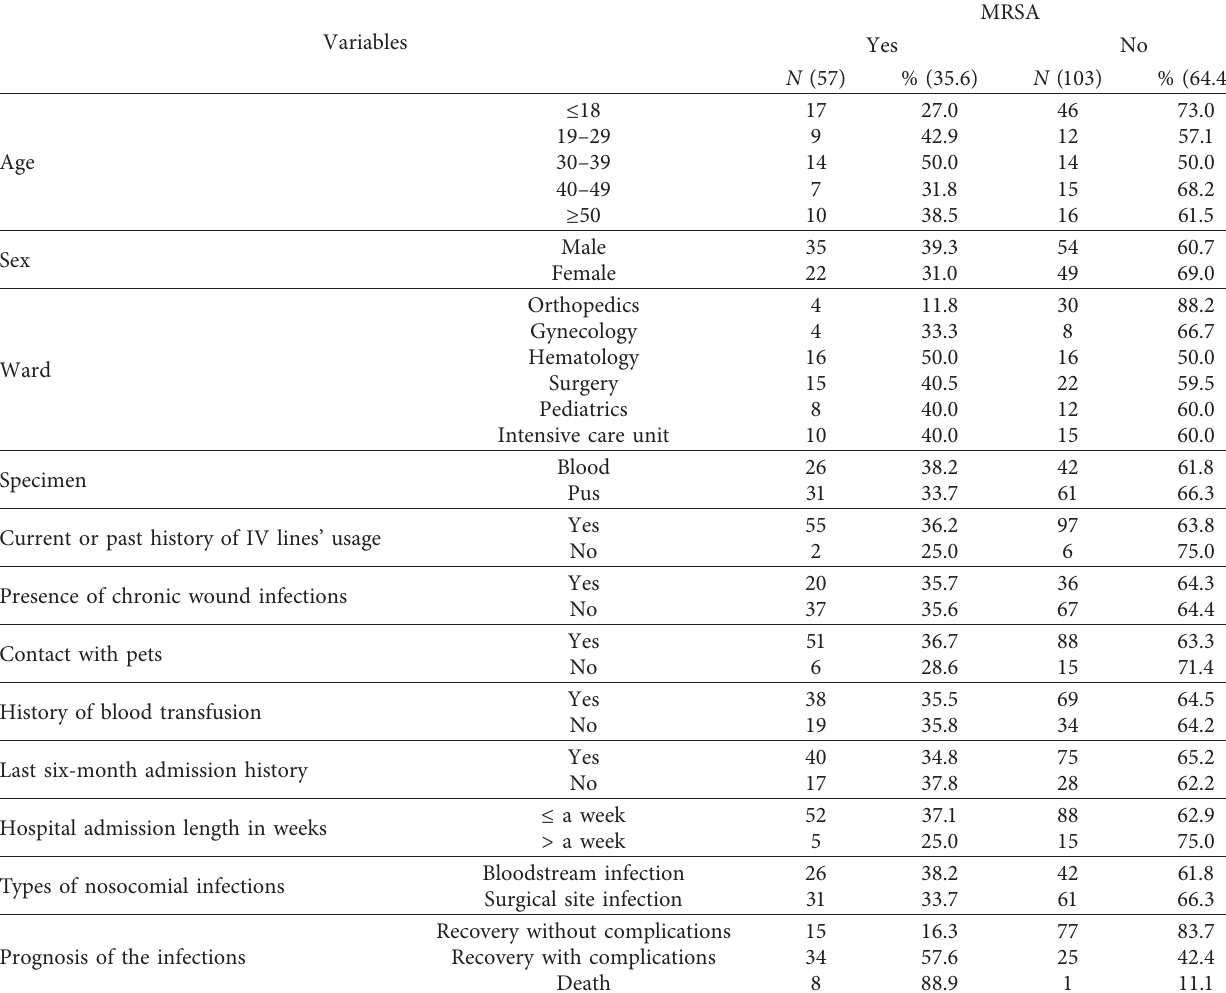
Table 1: Magnitude of MRSA among patients admitted to Tikur Anbessa Specialized Hospital, Addis Ababa, Ethiopia, from January 2018 to January 2019 ( n �